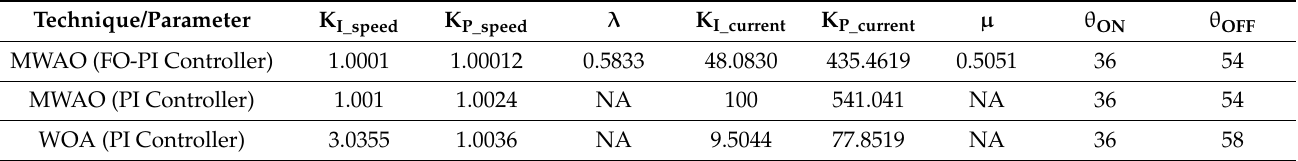
Table 10. Optimal gain of different parameter and commutation angle of FO-PI and PI controller.